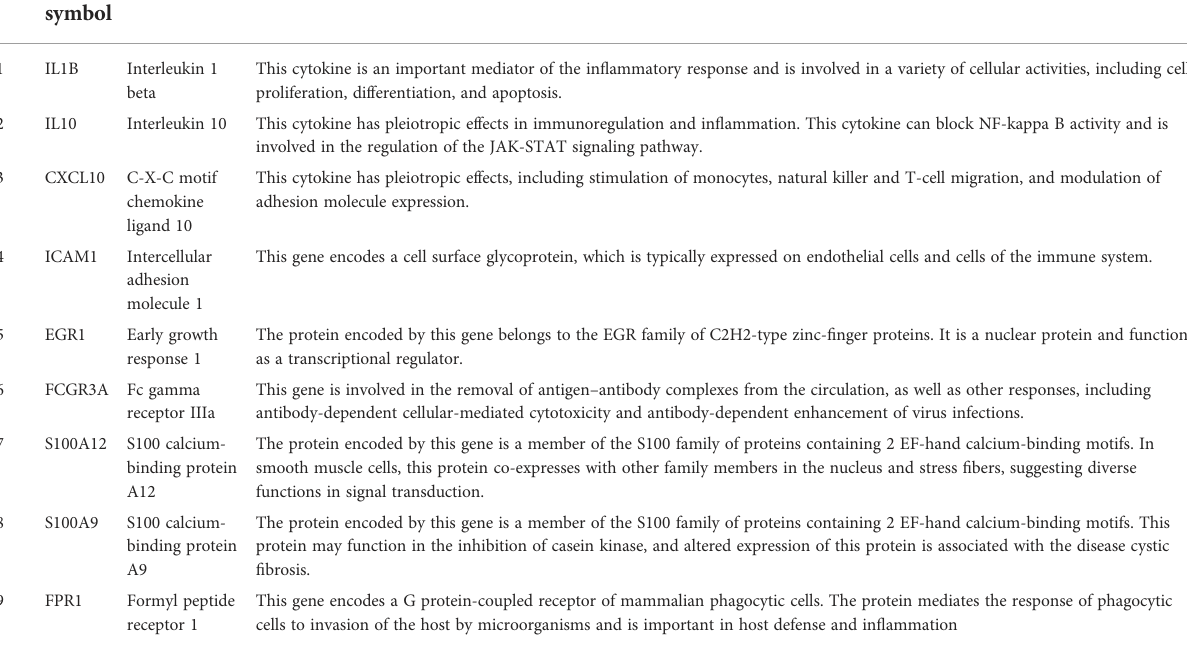
TABLE 2 The detail of hub